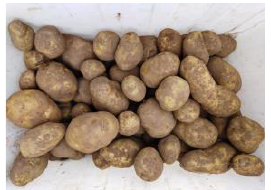
Ultrasonic vibration plate